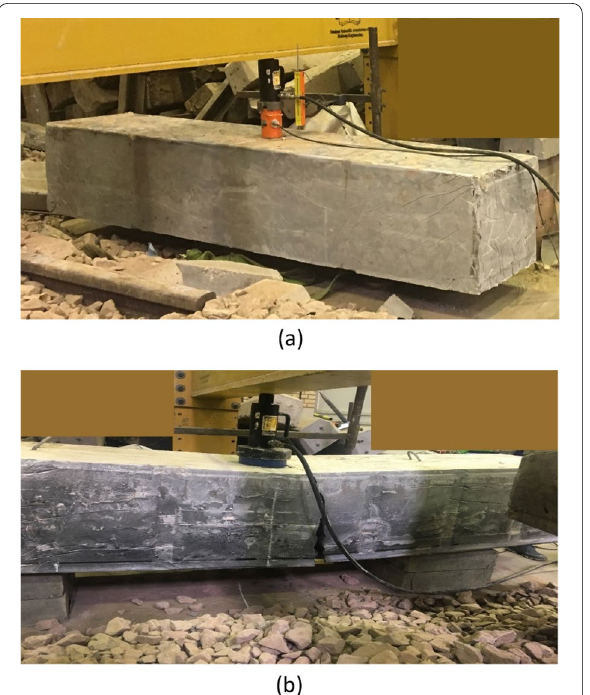
Fig. 15 Loading of the sleeper-excluded beam: a elastic area, b brittle failure.